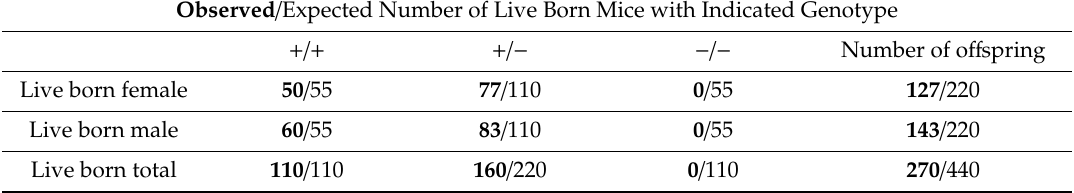
Table 1. Postnatal genotype distribution for o ff spring from Atxn2l +/ − intercrosses.